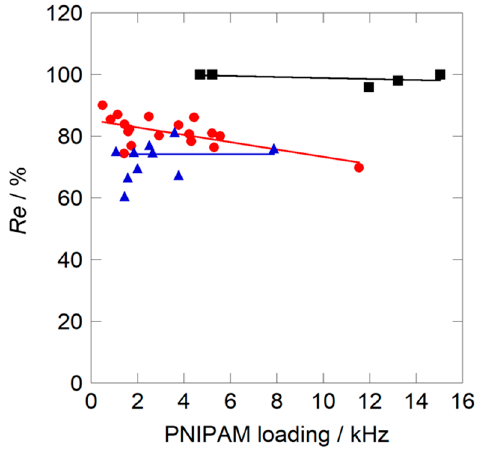
Figure 7. Dependence of the recovery of the sensor on PNIPAM loadings measured at 30 °C: ( ● ) X M = 0.2; ( ▲ ) X M = 0.3; ( ■ ) X M = 0.